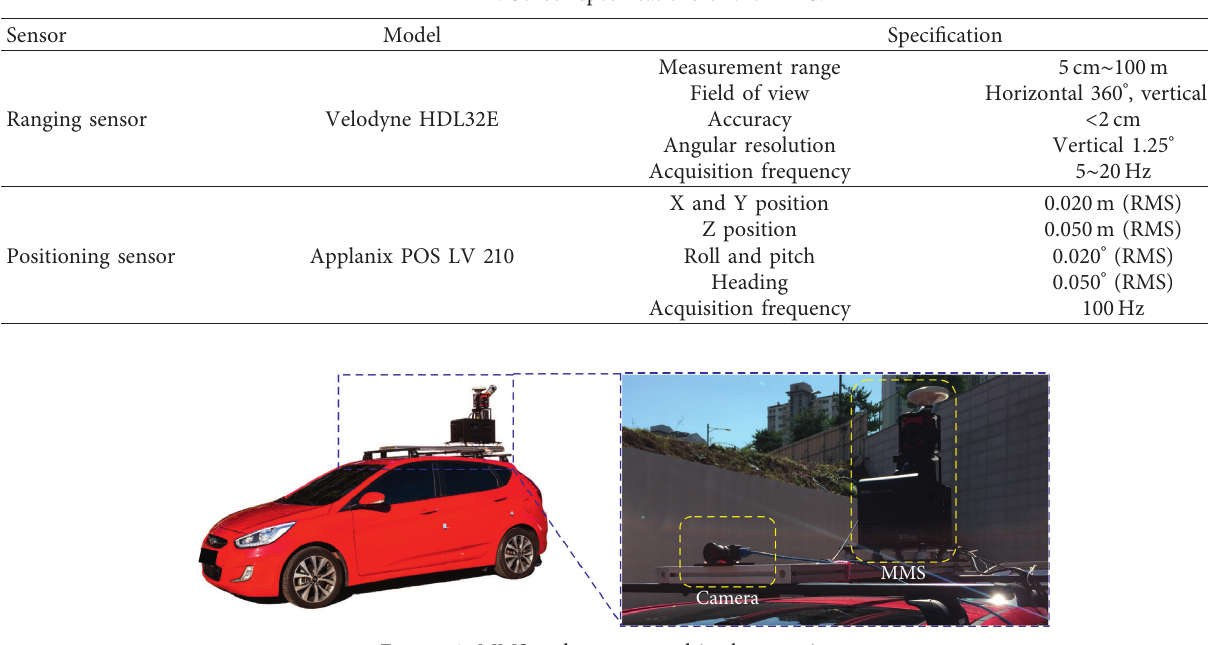
Figure 8: MMS and camera used in the experiment.